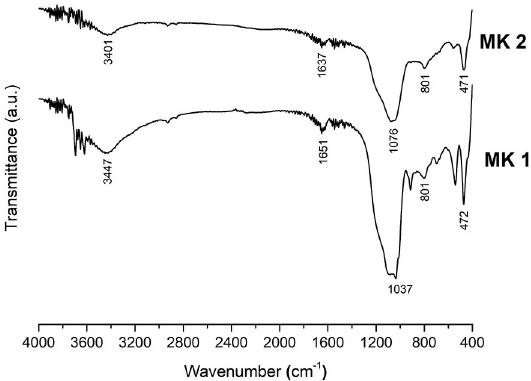
Figure 2. FTIR spectra of raw metakaolins.